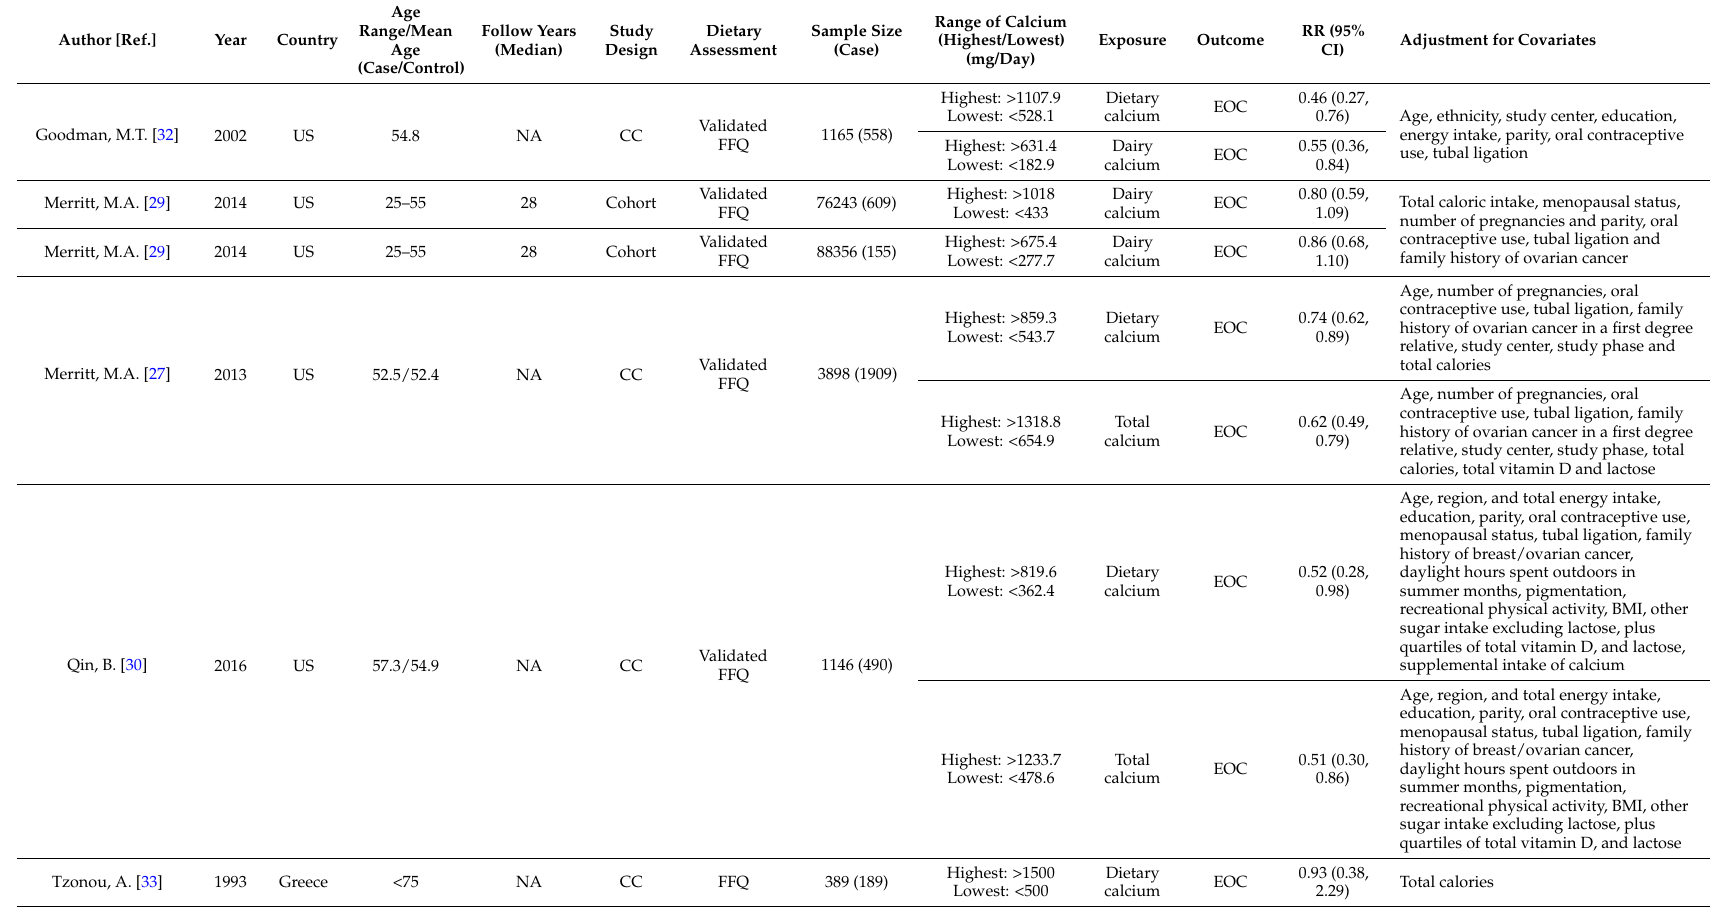
Table 1. Characteristics of the studies included on the intake of calcium and the risk of ovarian